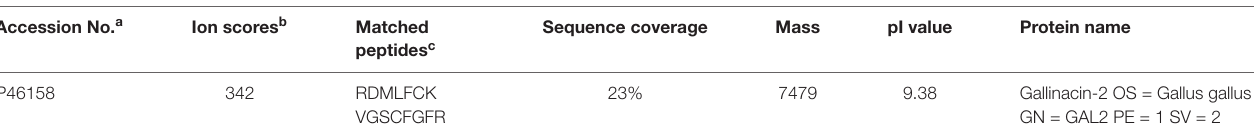
for another 36 or 48 h. Fold change of mRNA expression in CEFs of each group were measured at 36 or 48 hpi using RT-PCR. Transcript level of AvBD2 was normalized to the levels of 18S rRNA in the same samples and gene expression is presented as the fold change relative to the uninfected group. All assays were performed in triplicate, and each bar is the mean ± SEM.